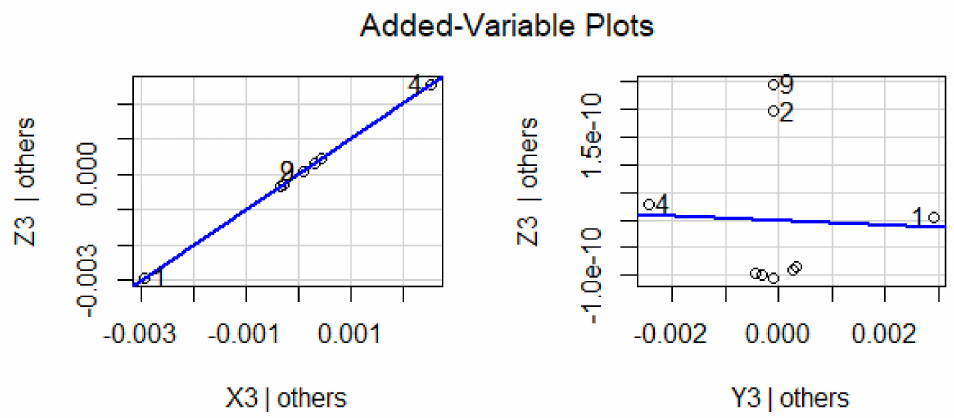
Figure 8. Representation of correlation among the dependent and predictor variables for a difference of 0.04 from the experimentally fixed value at 420 ◦